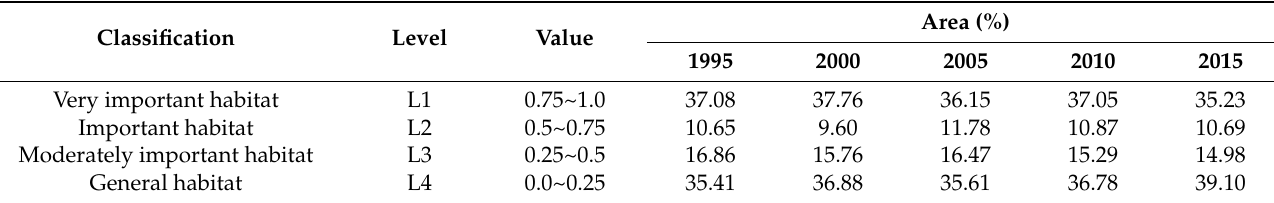
Table 5. The area of different habitat quality